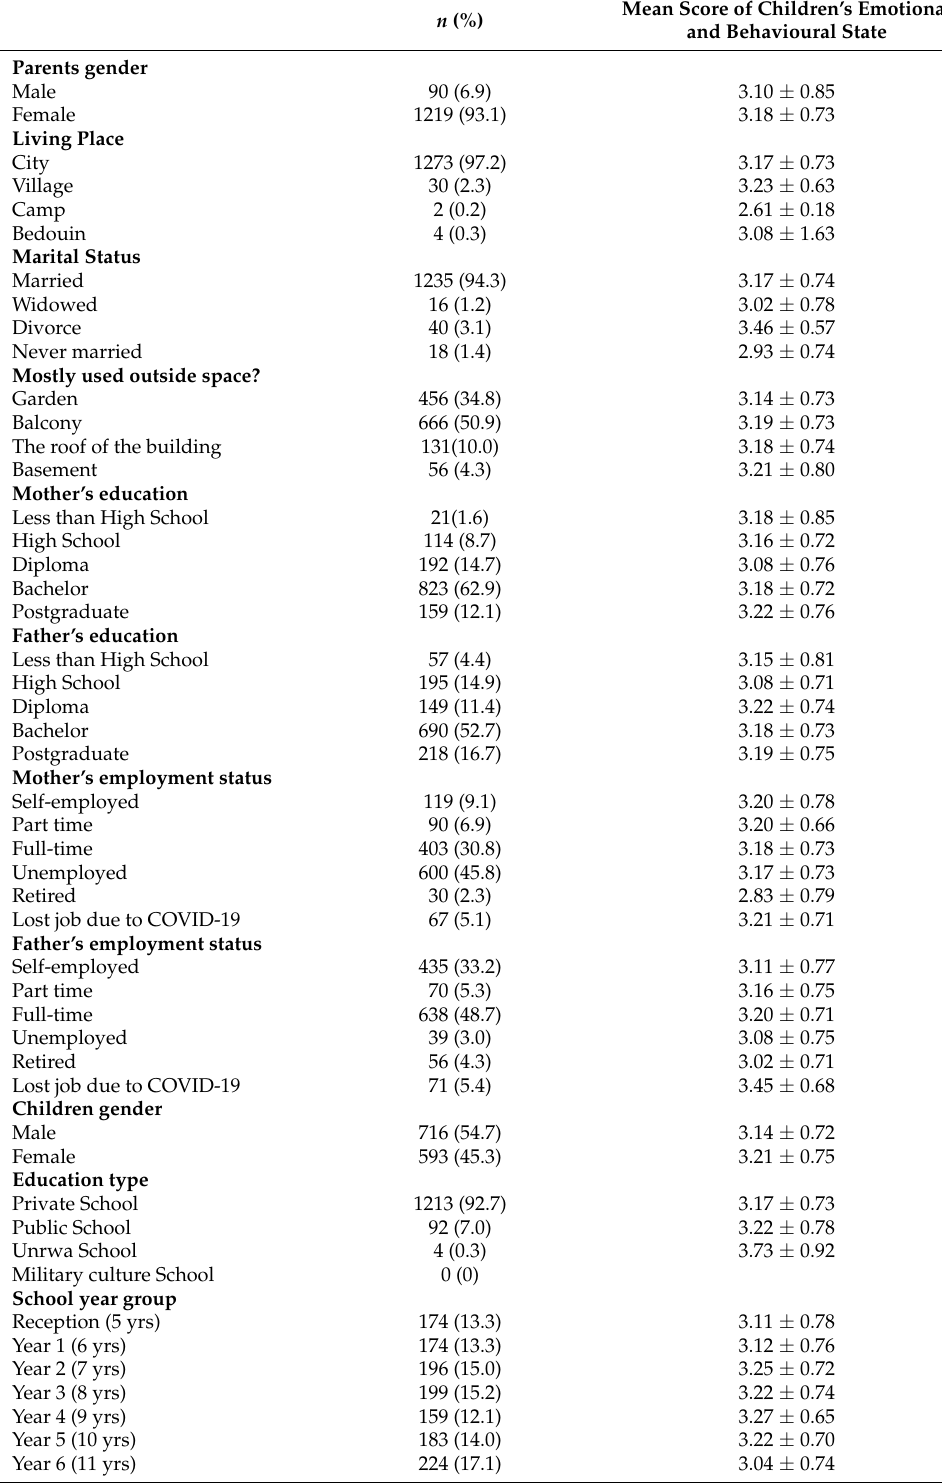
Table 1. Participant sociodemographic characteristics and mean score of parents perceived changes in children’s emotional and behavioural